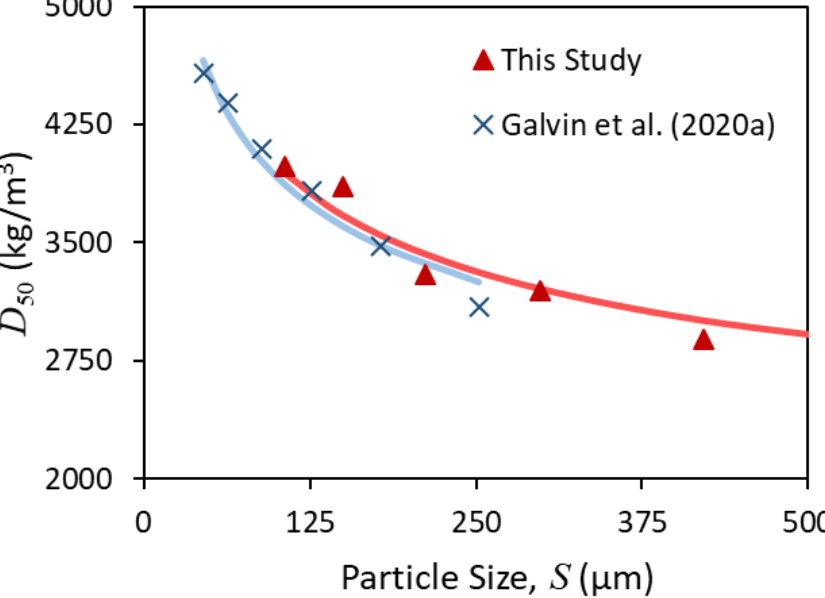
Figure 6. D 50 as a function of particle size comparing the experimental values from this study as well as those of Galvin et al. [17] with the model shown in Equation (3). Here, n = 0.28 and S 0 = 300 µm. A least squares curve fit was used to find D 0 for each dataset. There is strong consistency between the model and experimental values. RC separation z = 3 mm.